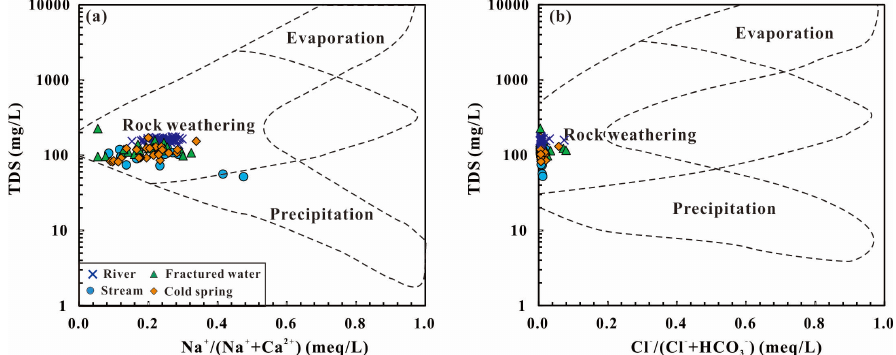
Figure 5. Gibbs plot. ( a ) Total dissolved solids (TDS) versus Na + /(Na + + Ca 2+ ); ( b ) TDS versus Cl − /(Cl − + HCO 3 − ).